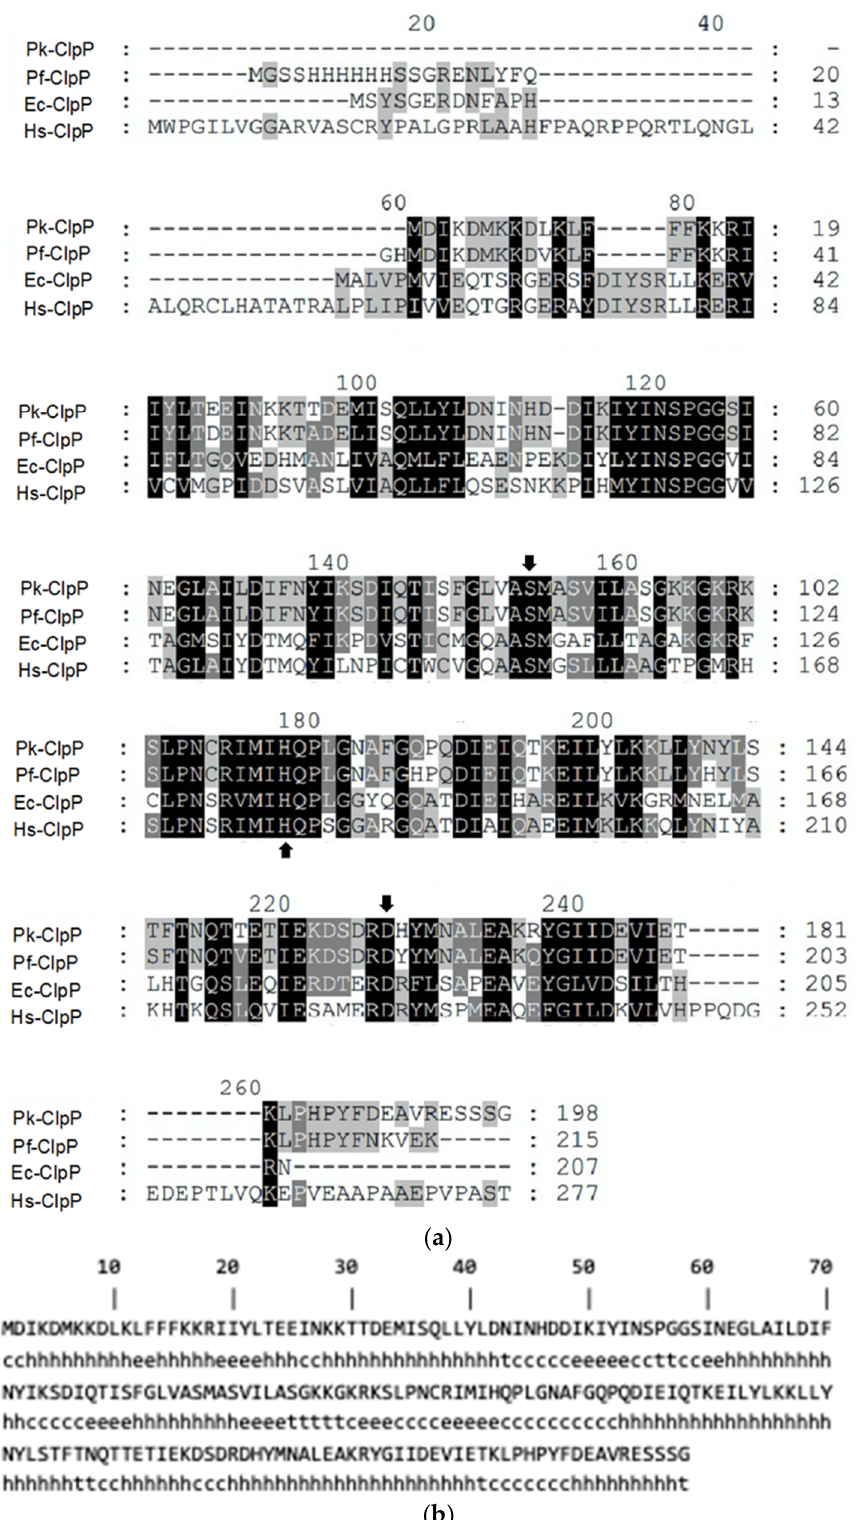
Figure 1. ( a ) Comparative amino acid sequence alignment of the ClpP from Plasmodium knowlesi (Pk-ClpP), P. falciparum (Pf-ClpP), Escherichia coli (Ec-ClpP), and human (Hs-ClpP). The catalytic triad of Ser-His-Asp is indicated by the arrow. ( b ) Secondary structure prediction by SOPMA. The motif of secondary structure is shown by the small letters below the sequence, where c, h, e, and t correspond to the random coil, -helix, β-sheet (extended strand), and β-turn, respectively. The * refers to every 10.